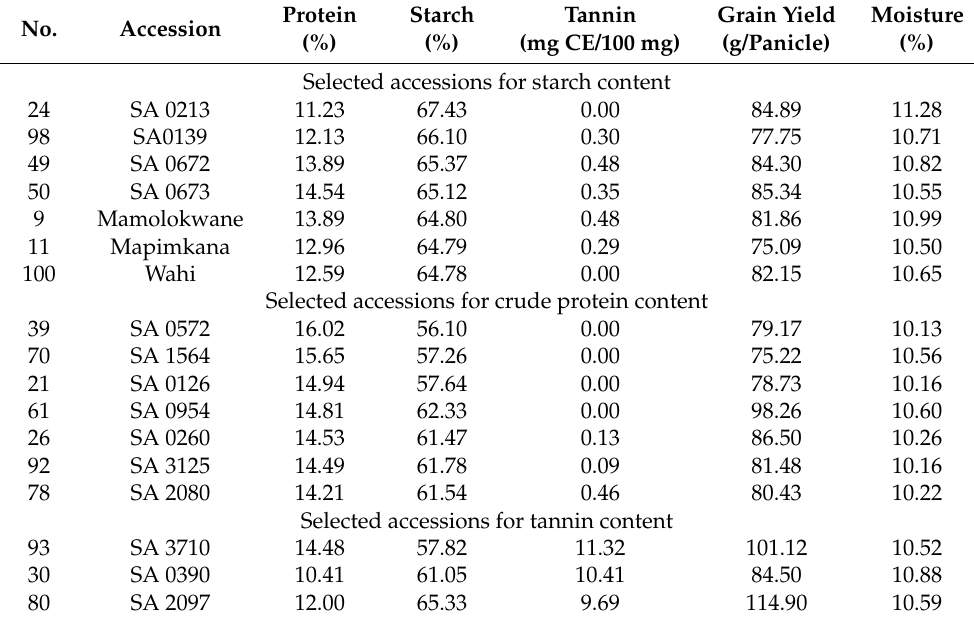
Table 4. Potential accessions selected for